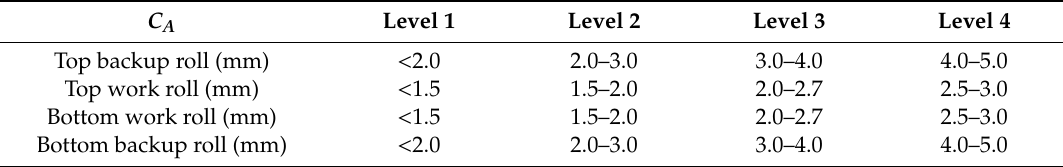
Table 7. Axial clearance management levels in the finishing line.